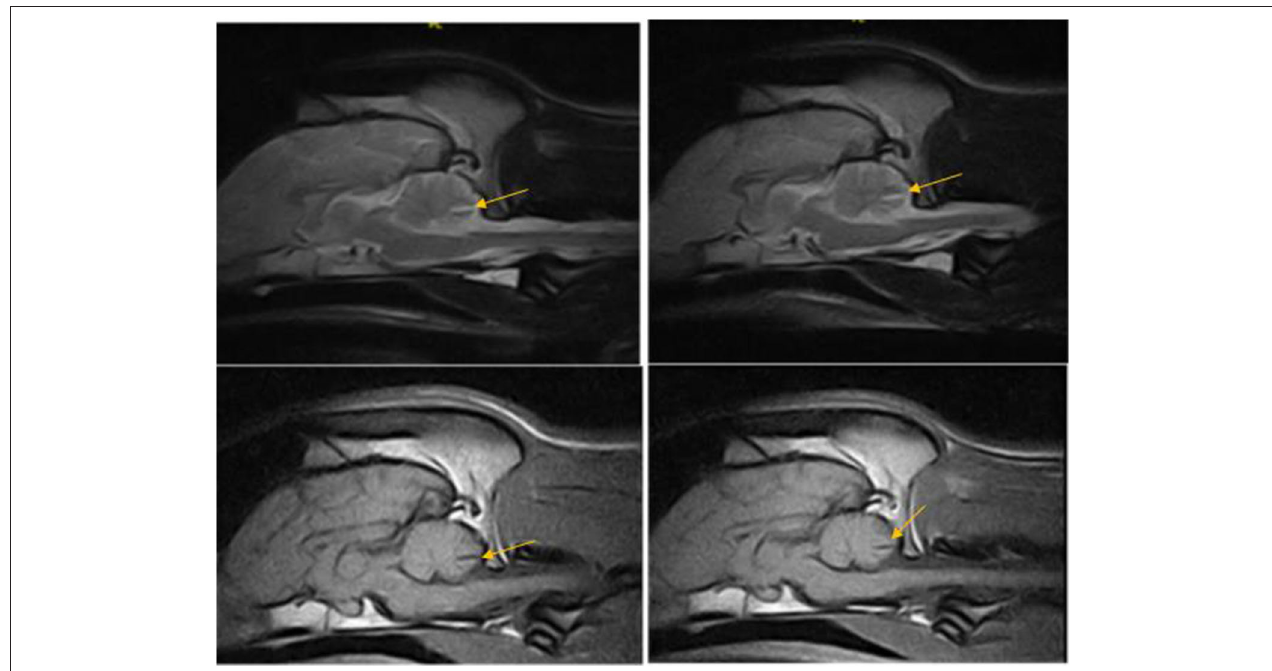
FIGURE 2 | T2W and T1W sagittal images of the dog in case 1 obtained 12 months apart showing non-progressive reduction in the tissue volume in the caudal cerebellar vermis indicated by deep wide sulci between the folia, particularly noted between pyramis and